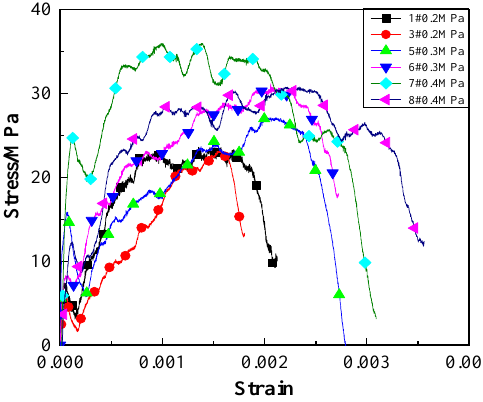
Figure 5. Test piece stress balance inspection.